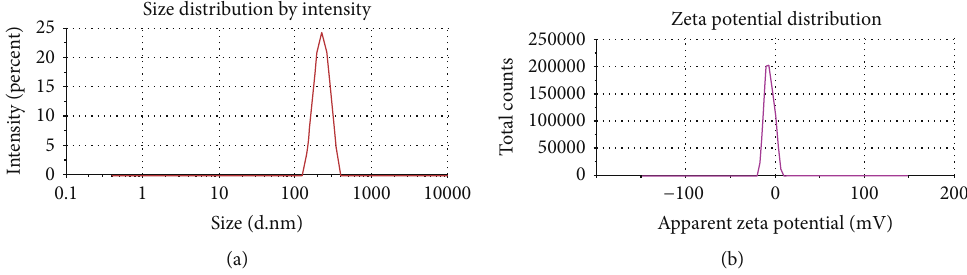
Figure 4: Illustration of the (a) size and (b) zeta potential of CUR-loaded PLGA nanoparticles.